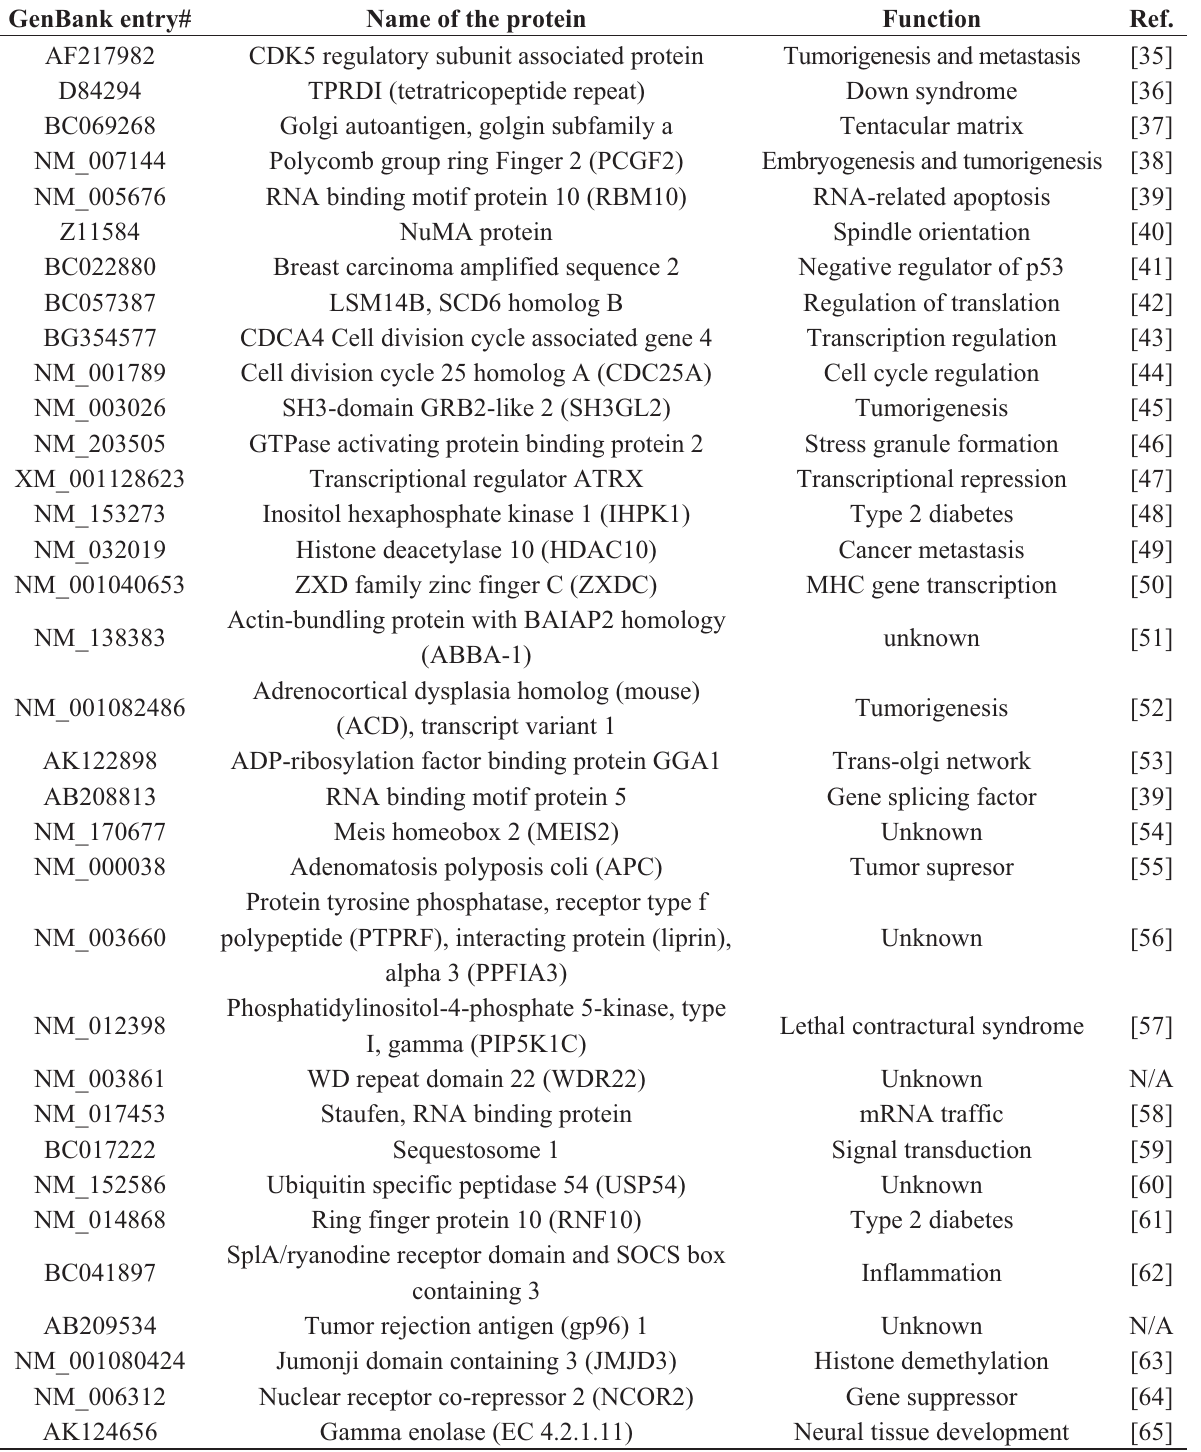
Table 1. List of the Human Cytomegalovirus (HCMV) IE1 Protein-Protein Interactions (PPIs) by Protein Array Assay. The positive spots in Figure 1A,B were listed in this table according to the manufacturer’s annotation table. The dots are all in doublets. Some genes overlap between the two PVDF membranes. Cellular Proteins Interacting with Human Cytomegalovirus IE1 (Identified by Protein Array